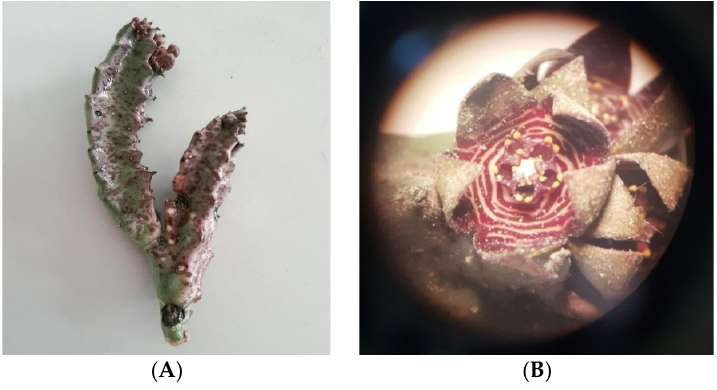
Figure 8. C. europaea aerial parts: ( A ) Stem; ( B ) Flower.